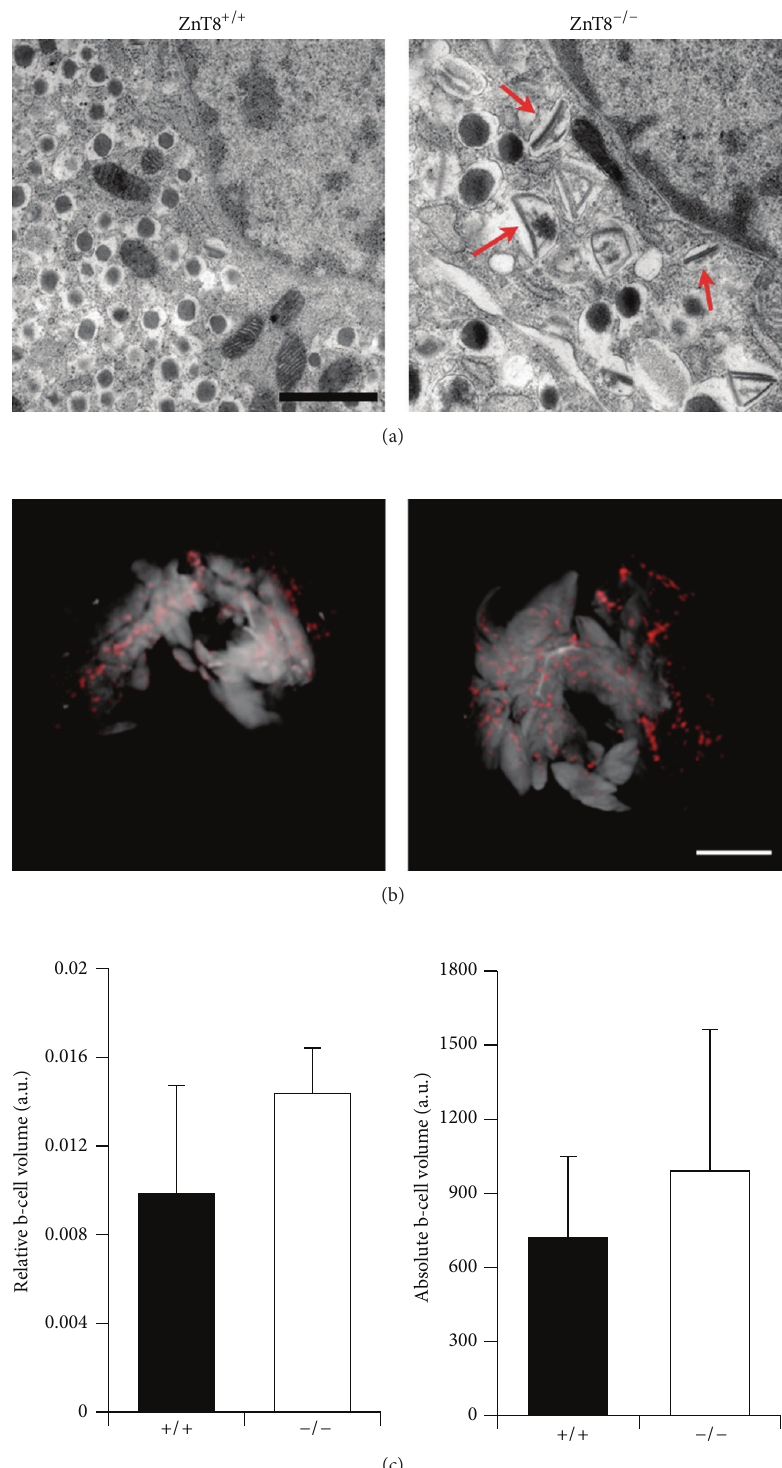
Figure 1: Electron Micrographs and Optical Projection Tomography (OPT) in ZnT8 +/+ and ZnT8 −/− mice. (a) Transmission electron microscopy images of isolated islets from ZnT8 +/+ and ZnT8 −/− male mice at high magnification (scale bar 1mm) reveals the appearance of rod-shaped core granules in ZnT8 −/− cells, indicated by red arrows ( 𝑛 = 3 mice). Sections were cut and images were acquired by Dr. Raffaella Carzaniga and Ms. Katrin Kronenberger. (b) Representative three-dimensional OPT projections of whole fixed and permeabilised pancreas from ZnT8 −/− and ZnT8 +/+ mice. In red are the insulin positive structures ( 𝛽 cells). The overall shape of the whole pancreas was visualized as autofluorescence and is apparent as white/grey shading. Scale bar = 1cm. (c) Relative (right panel) and absolute (left panel) 𝛽 -cell volume ( 𝑛 = 2 pancreata per